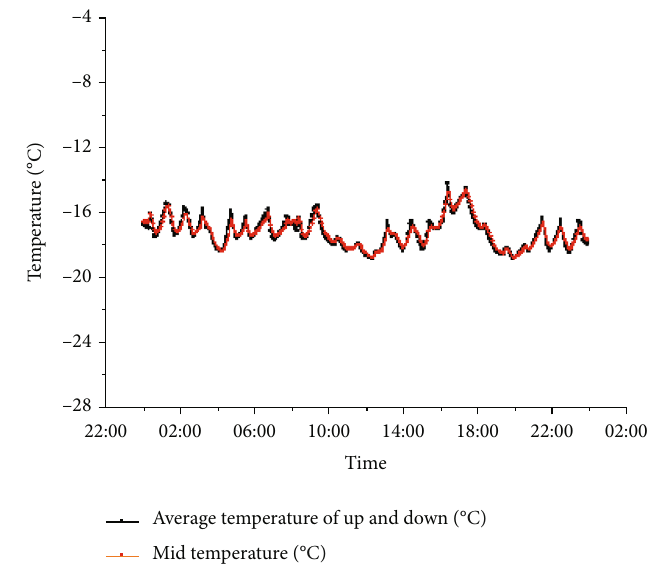
Figure 4: Average temperature and midtemperature of measuring points at vertical position